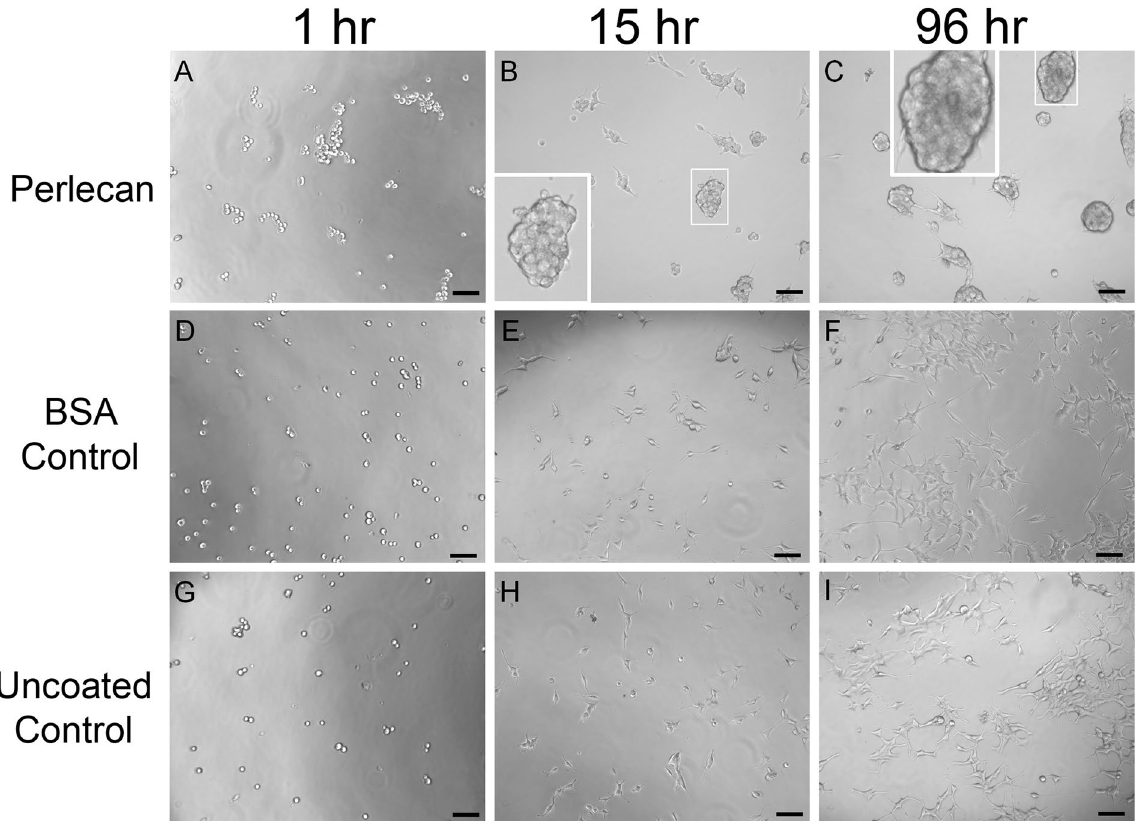
Figure 1. Full length perlecan induces clustering in prostate cancer cells over time. C4-2B cells were seeded into wells coated with perlecan ( A–C ), BSA ( D–F ), or tissue culture plate only ( G–I ) and imaged over a 96-hour period. Cells on perlecan begin clustering at one hour and is more pronounced later (15 and 96 hours) (white boxed inset enlarges clusters). Cells seeded on BSA coated plates lack any observable difference between the plate only, becoming adherent and spreading out in both cases. Scale bars: 100 µ